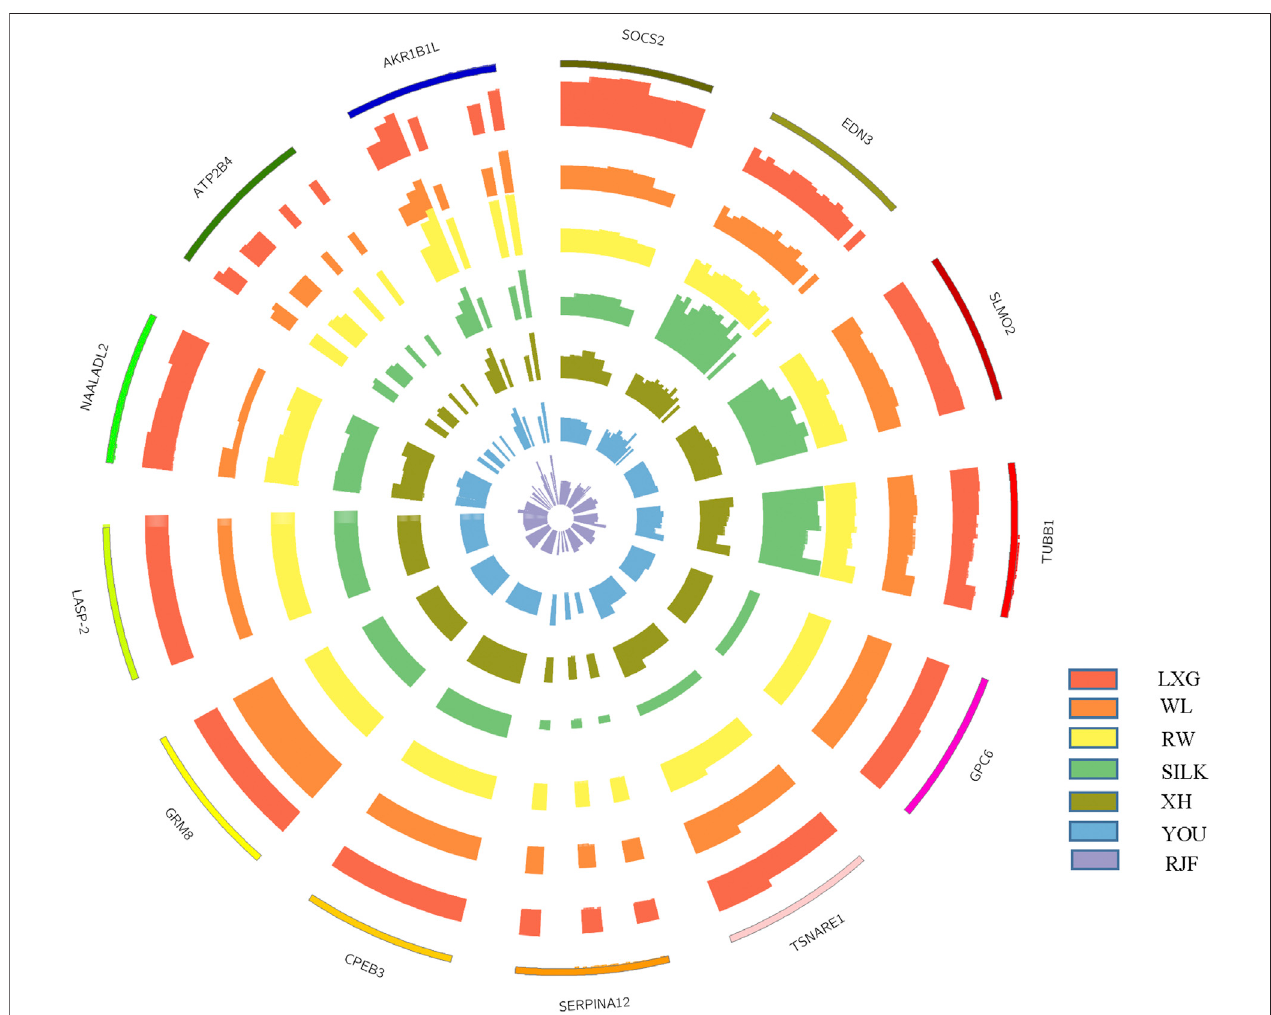
FIGURE 2 | The schematization for a part of copy number variation genes distinguished in different chicken breeds. The outermost circle indicates the CNV- involvedgeneregions,withthethicknessimplyingthenormaldiploid.TheothercirclesfromoutsidetoinsideindicatethebreedsofLuxiGamefowl(LXG),WhiteLeghorn (WL), Recessive White Rock (RW), Silkie (SILK), Xinghua (XH), Beijing You (YOU), and red jungle fowl (RJF) in turn, whose thickness proportionally means the estimated copy